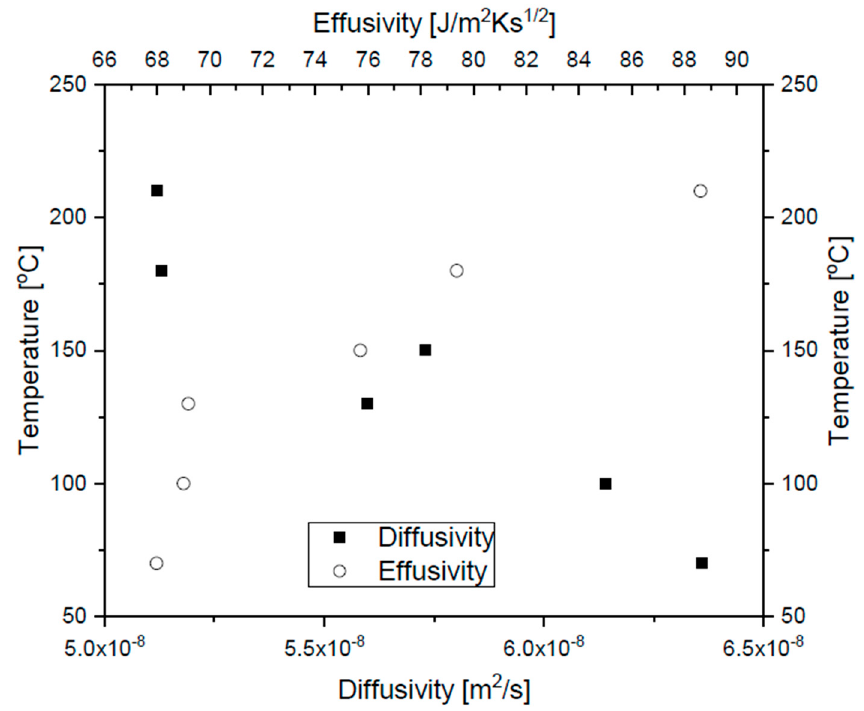
Figure 2. Thermal diffusivity and effusivity versus temperature.